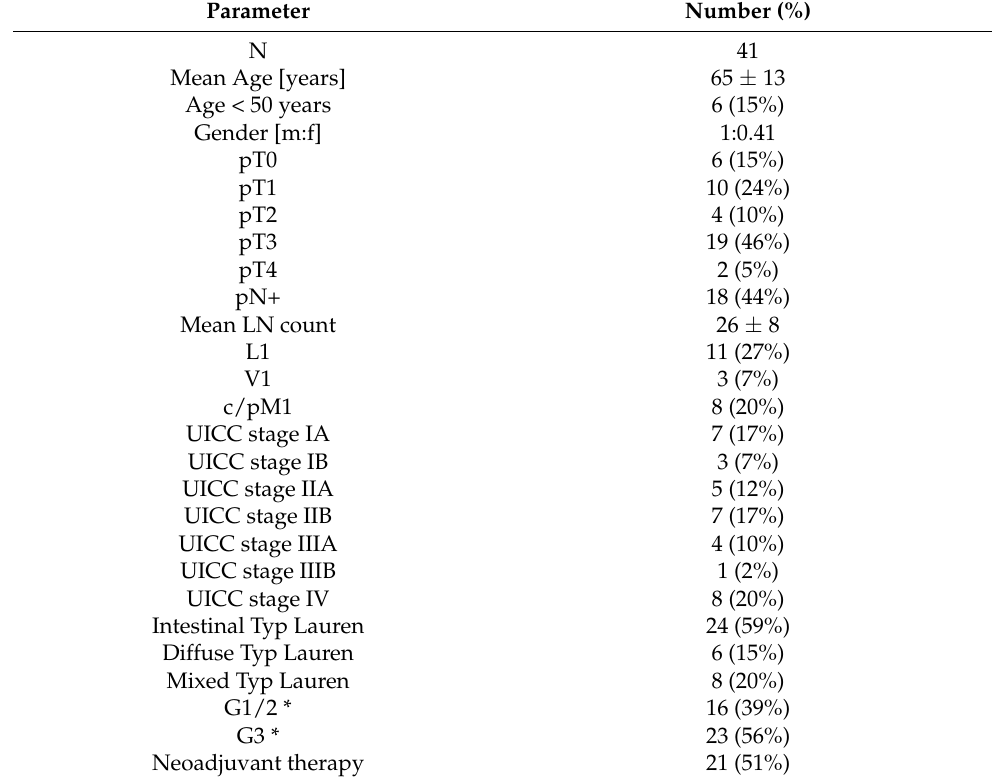
Table 1. Clinicopathological